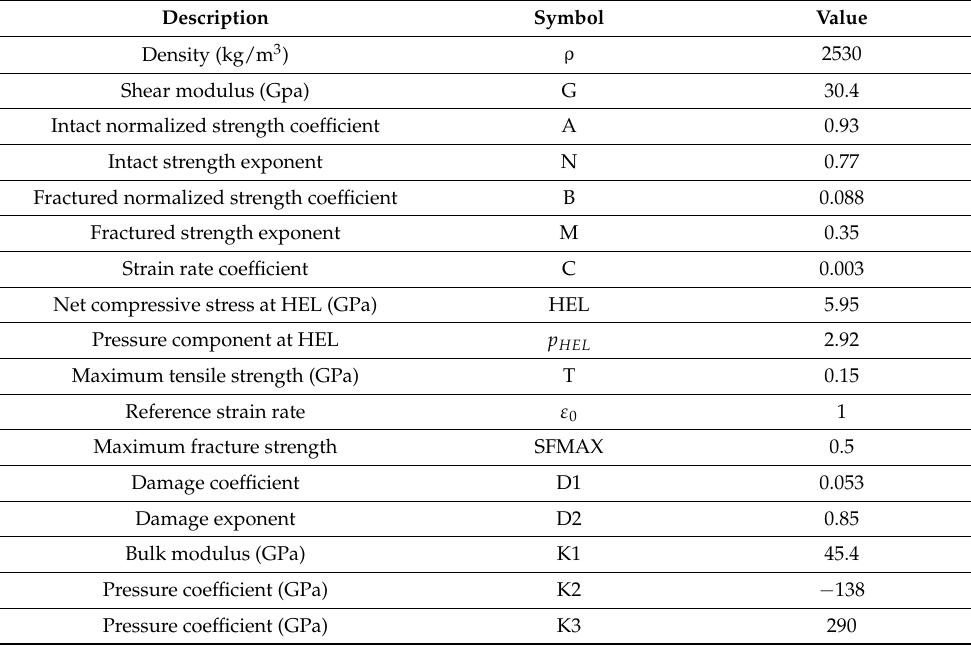
Figure 1. Smooth particle hydrodynamics (SPH) model of a single particle impacting the optical glass. Table 1. JH-2 parameters of optical glass [37] .